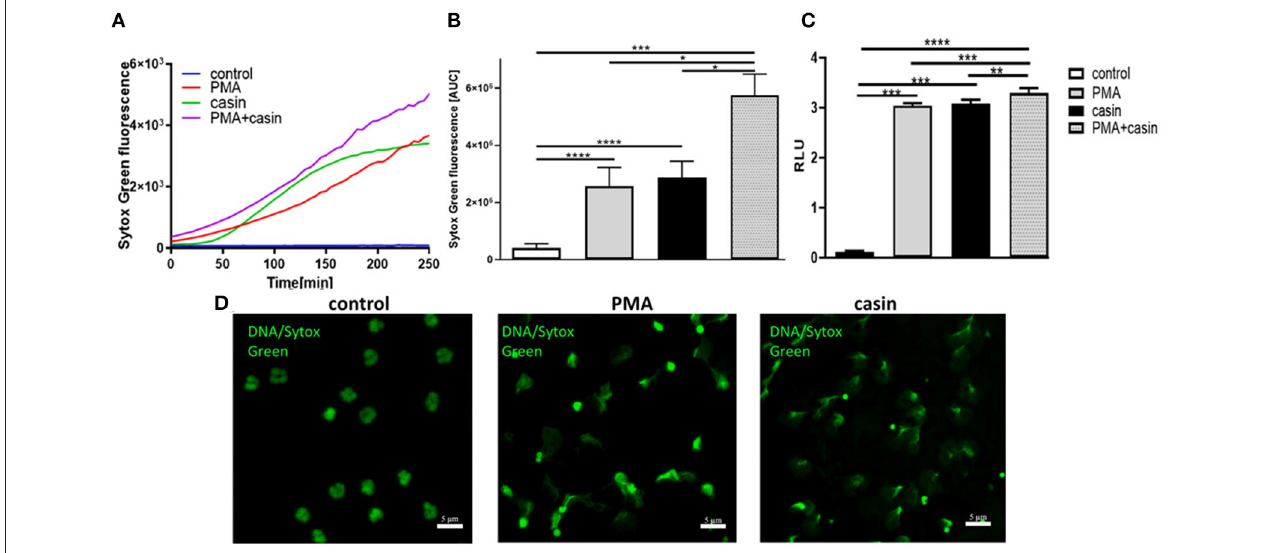
FIGURE 1 | Cdc42 is a negative regulator of NET formation. Freshly isolated human neutrophils were seeded into a fluotrac 96-well plate and 5 µ M Sytox Green was subsequently added to all samples. The formation of NETs without stimulation, with 20nM PMA, with the Cdc42 inhibitor casin (10 µ M) or a combination of PMA (20nM) plus casin (10 µ M) was detected over a period of 4h at 37 ◦ C by measuring the fluorescence of DNA bound Sytox Green or by taking supernatants and performing an MPO-bound DNA ELISA. (A) Representative graph showing the Sytox Green fluorescence over time. (B) Quantification of NET release by calculating the area under the curve (AUC) from Sytox Green kinetic curves. (C) Quantification of NET release by measuring the OD at 405nm of MPO-bound DNA, displayed as relative light units (RLU). Data show mean ± SD of 8 independent experiments. **** p ≤ 0.0001, *** p ≤ 0.001, ** p ≤ 0.01, and * p ≤ 0.05. (D) Visualization of DNA bound Sytox Green using fluorescence